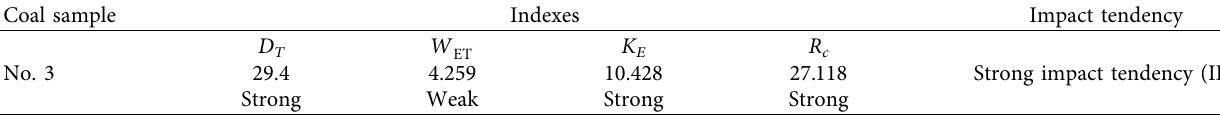
Table 2: Testing result of #1 coal samples impact tendency.